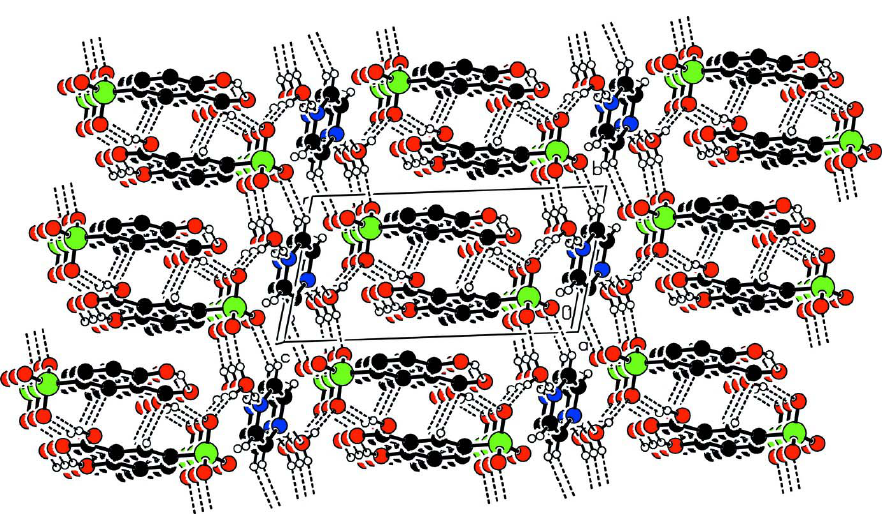
Molecular structure of the title salt showing the atom-numbering scheme. Displacement ellipsoids are drawn at the 50% probability level. H-bonds are shown in dashed lines. Symmetry code: (A) 2 - x , 1 - y , 2 - z .